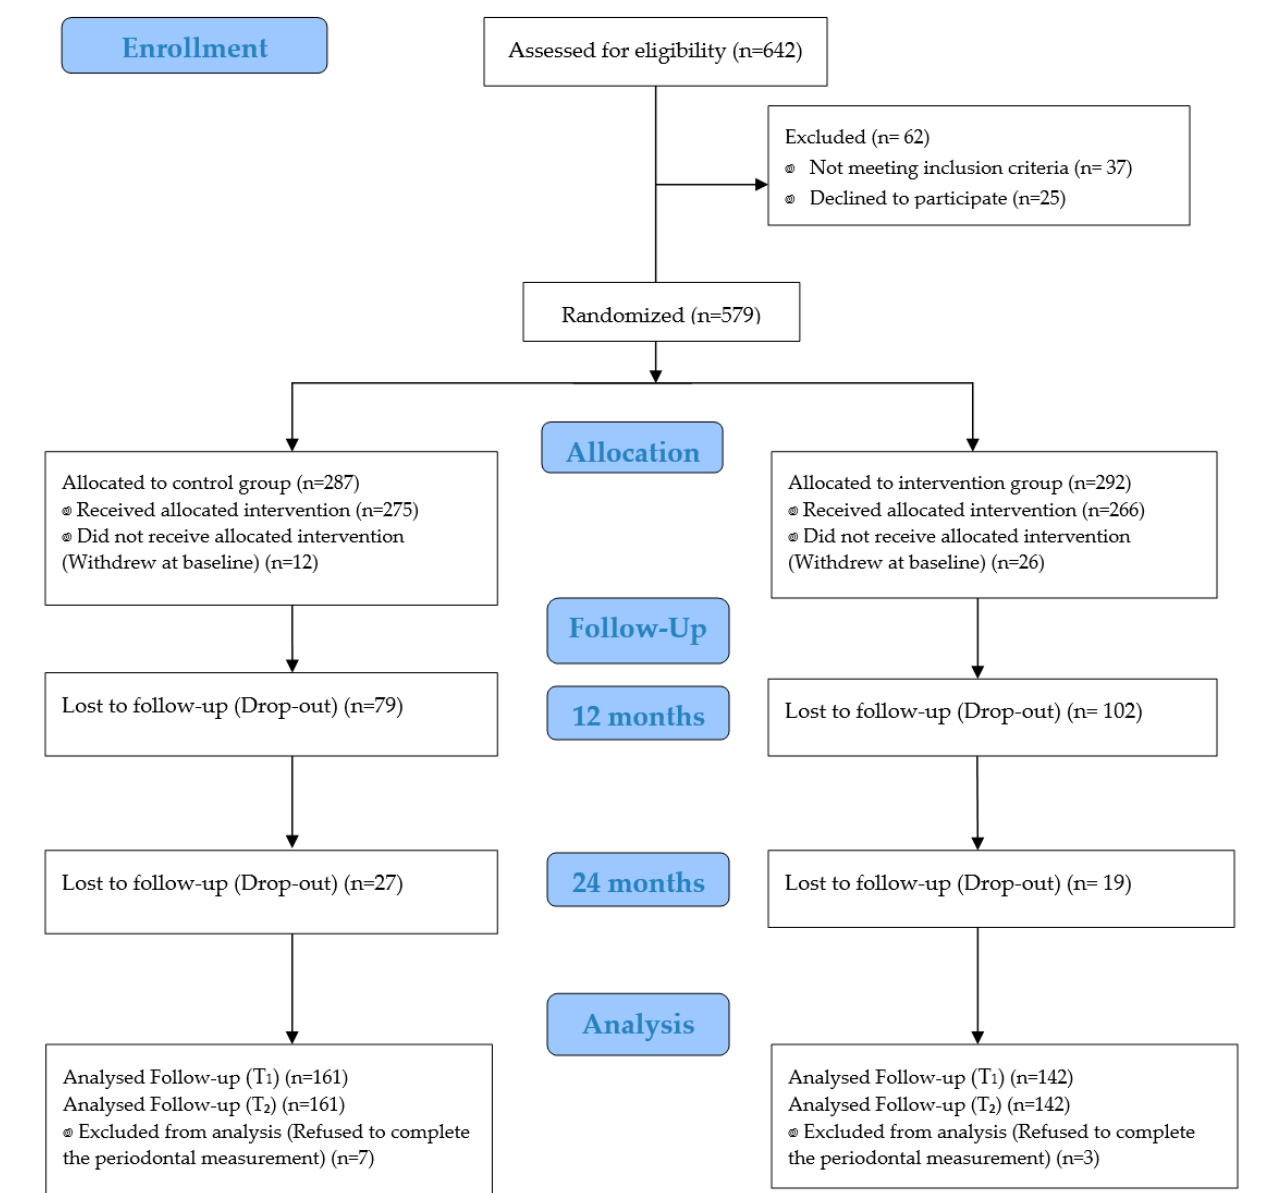
Figure 1. CONSORT (Consolidated Standards of Reporting Trials) flow chart of participant recruitment. Table 1. Demographic and baseline characteristics of participants.